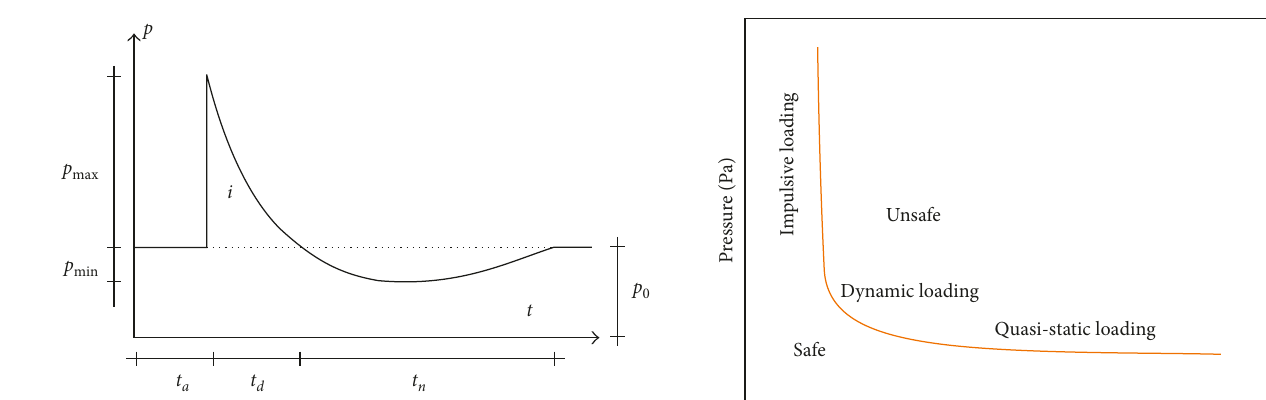
Figure 2: Pressure-time history for an ideal free-field air-blast